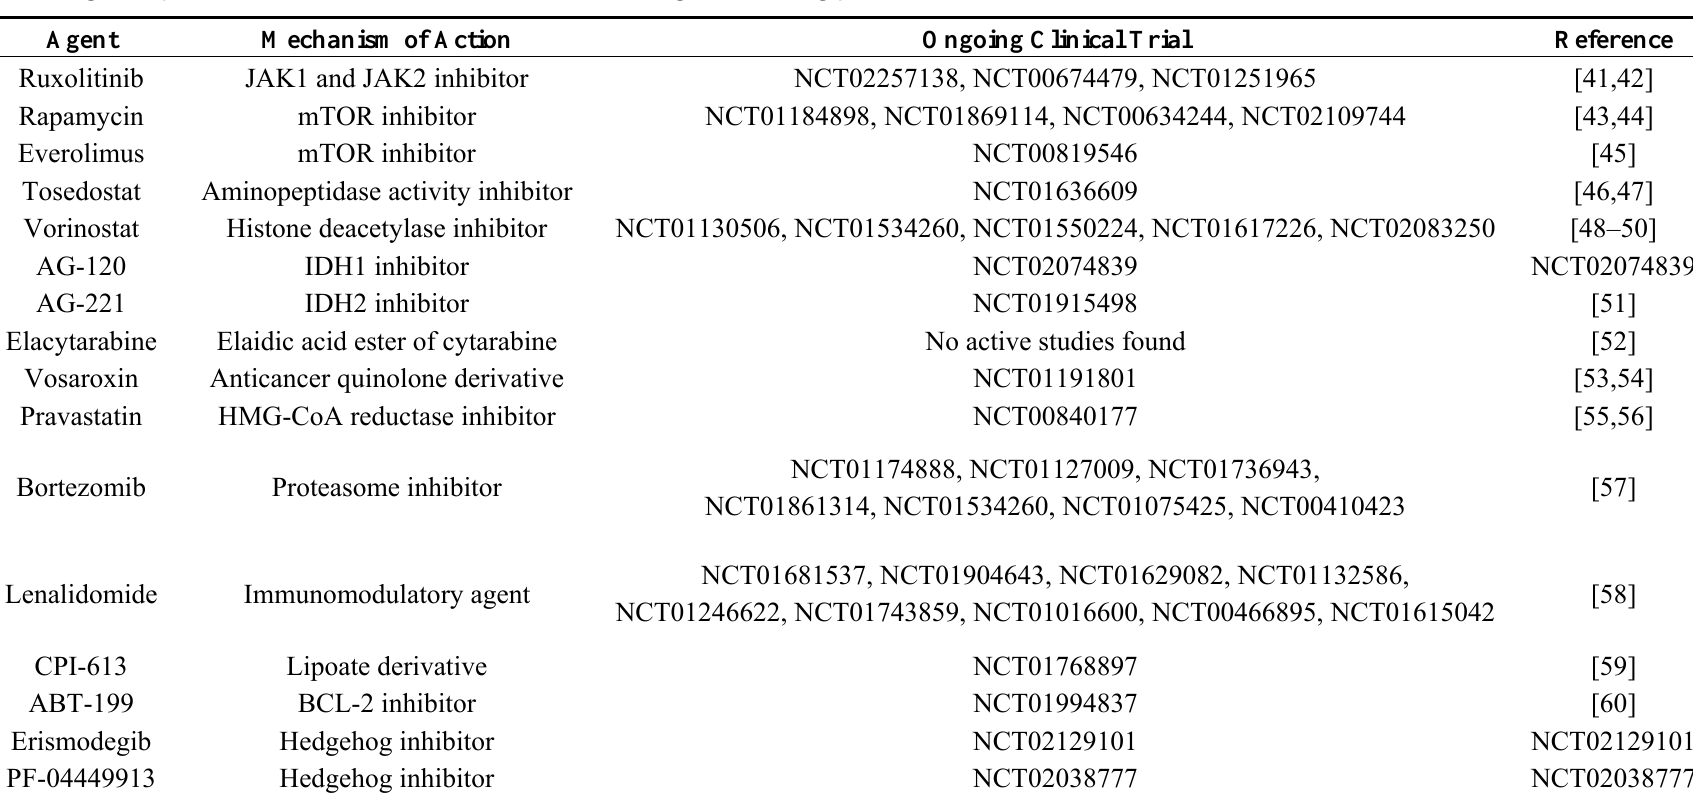
Table 2. Targeted agents under evaluation for treatment of patients with relapsed/refractory AML (RR-AML). Ongoing clinical trials (either enrolling new patients with RR-AML or active but no longer enrolling